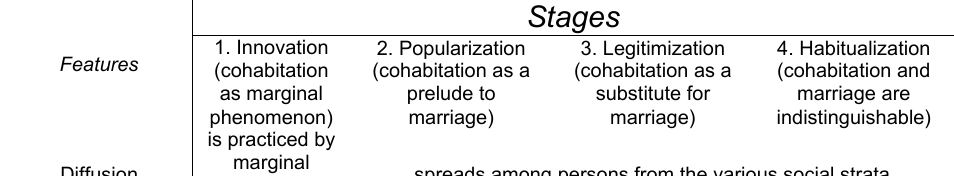
Table 1. The stages of the spread of cohabitation